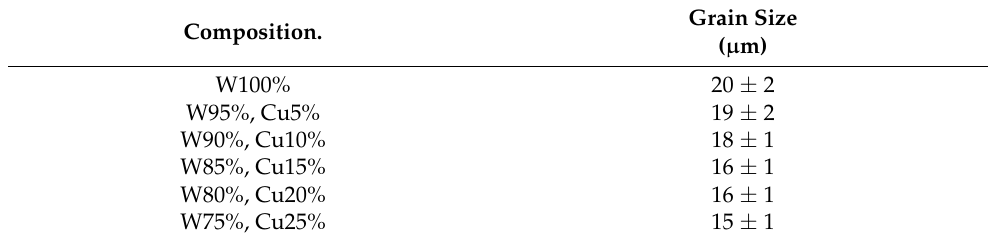
Table 2. Grain size (of tungsten).